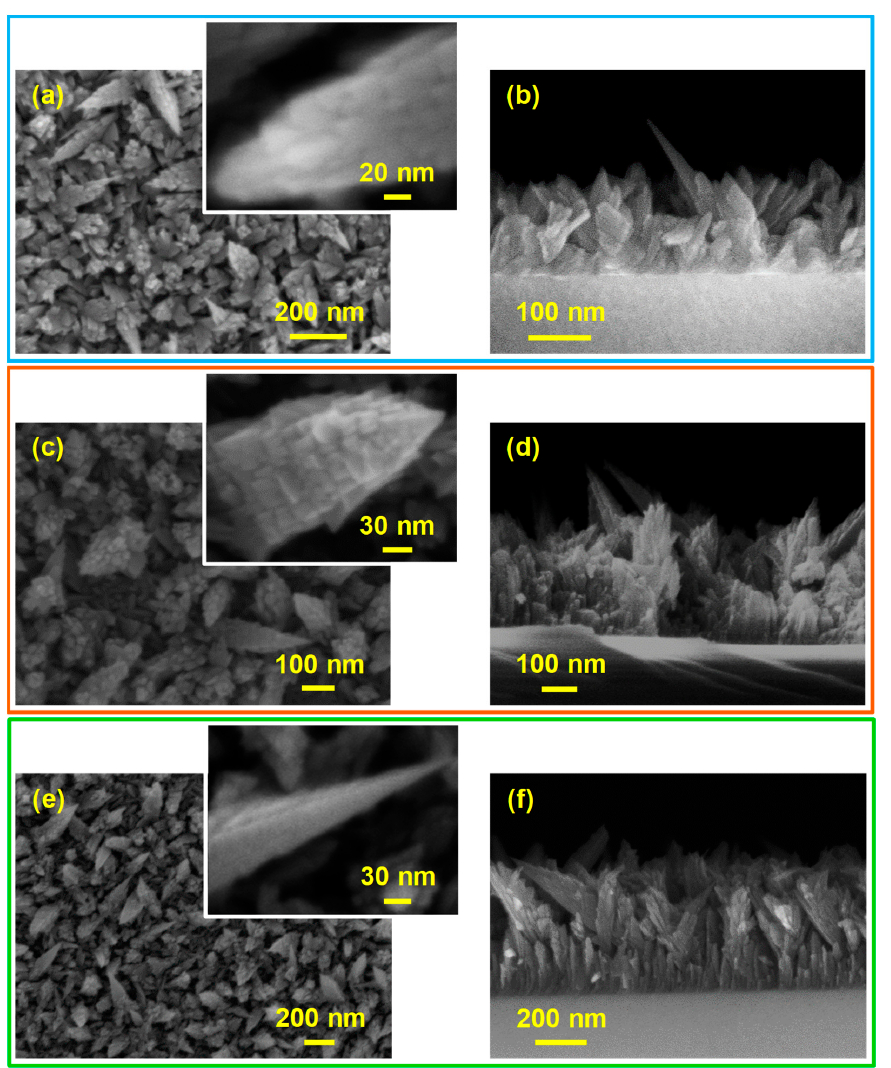
Figure 3. Representative plane-view (left) and cross-sectional (right) FE-SEM images for MnO 2 nanostructures grown on MgAl 2 O 4 (100) ( a , b ), YAlO 3 (010) ( c , d ), and Y 3 Al 5 O 12 (100) ( e , f ).